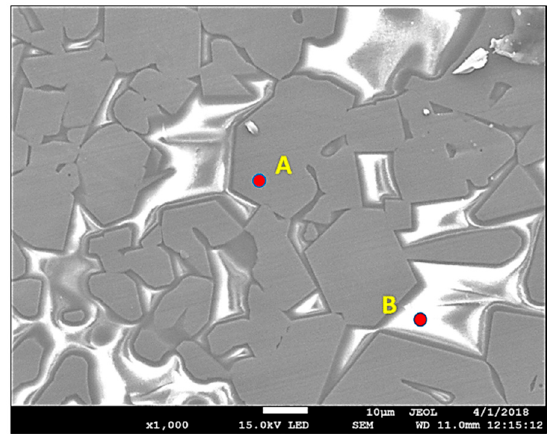
Figure 11. SEM-EDS of sinter sample adding 5% B 2 O 3.